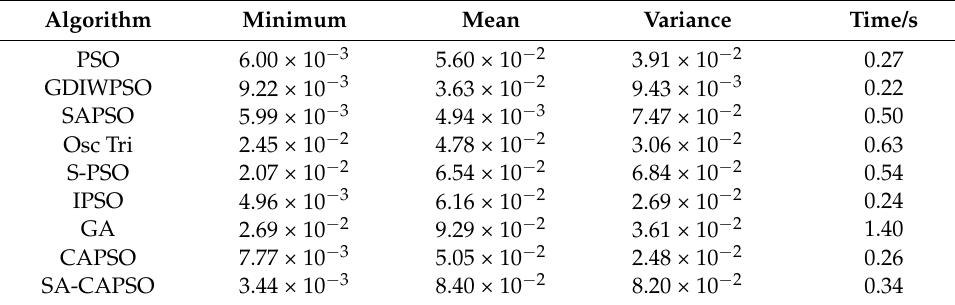
Table 9. Test results of test function F2.